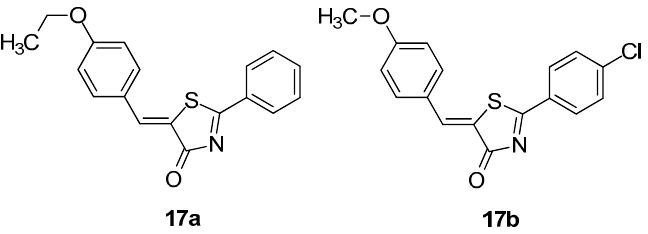
Figure 19. Chemical structures of 5-benzylidene-2-phenylthiazolinones 17a , 17b .